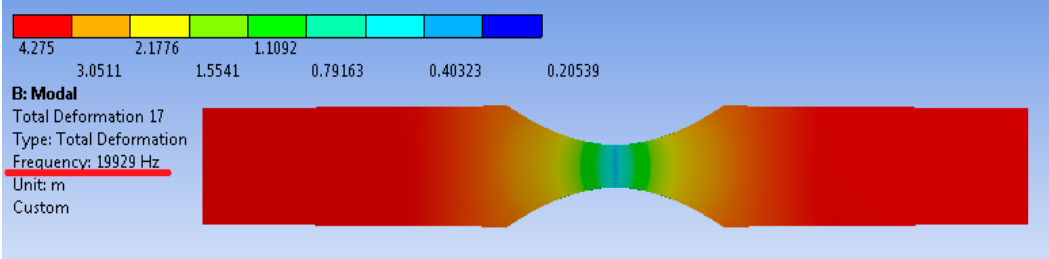
Figure 2. Natural frequency of vibration in longitudinal direction for aluminum alloy specimen